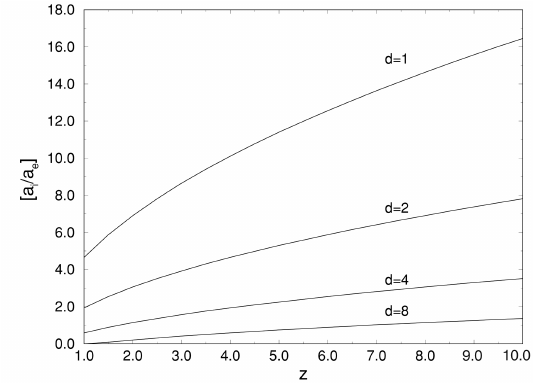
Fig. 2. Effect of disturbance penetration depth d and size ratio z /a for elliptical shapes (k=3). To calculate the actual patch on a i e size, z is multiplied by 500 (z<1 ≥ a<500; z=1 ≥ a=500; z>1 ≥ a>500). An increase of a decreasing d.